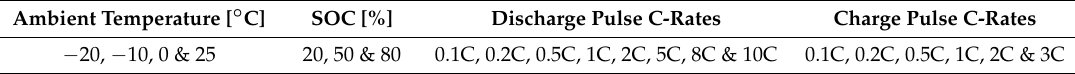
Table 2. Test Matrix for Pulse Power Characterization of Lithium-ion Pouch